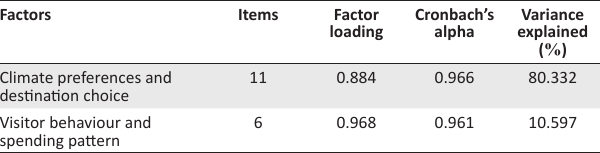
TABLE 5: Exploratory factor analysis result.